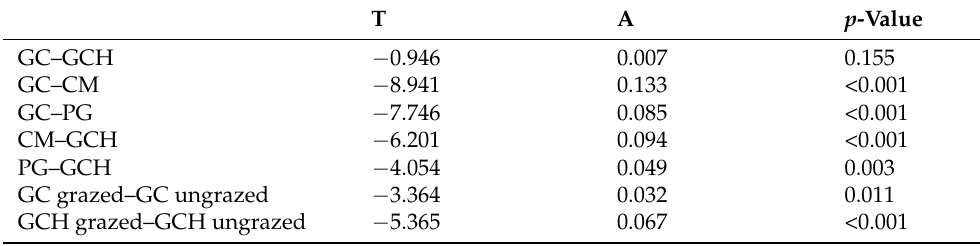
Table 3. Results of the multi-response permutation procedure (MRPP) for carabid assemblage in fall, revealing significant differences comparing the grass–clover pastures GC and GCH to CM and PG. T is the test statistic calculating the difference between observed and expected delta, while A is the chance-corrected within-group